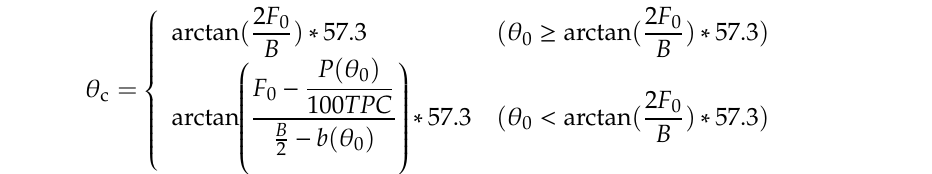
Figure 9. Heeling angle and heeling time θ 0 = 0°.